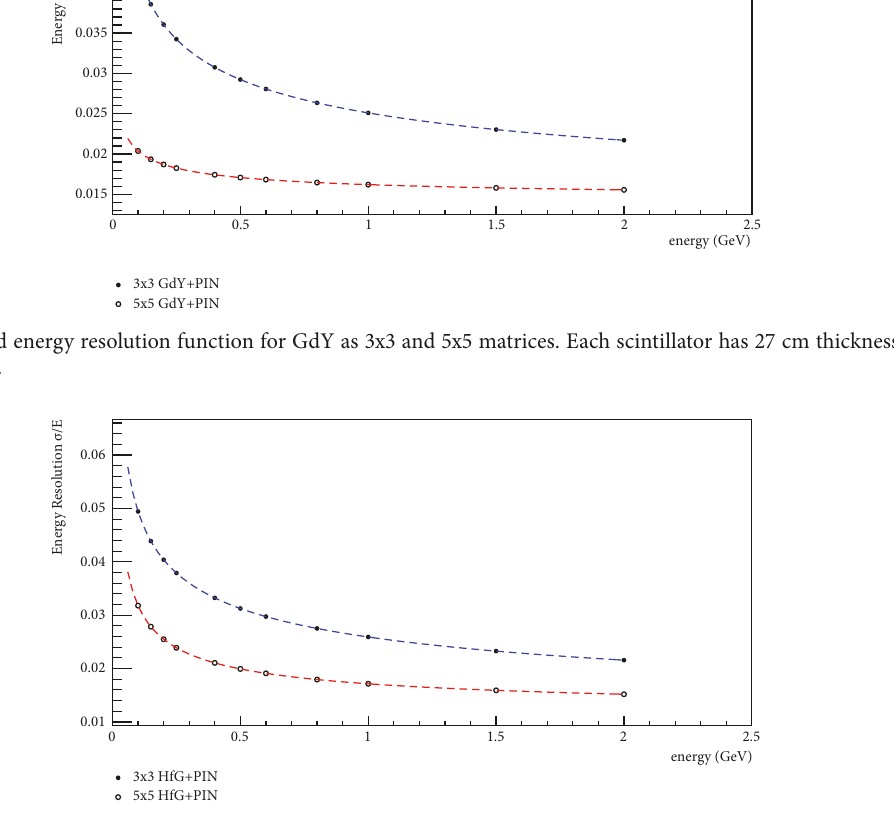
Figure 10: Parameterized energy resolution function for HfG as 3x3 and 5x5 matrices. Each scintillator has 27 cm thickness and back face area of 25 mm × 25